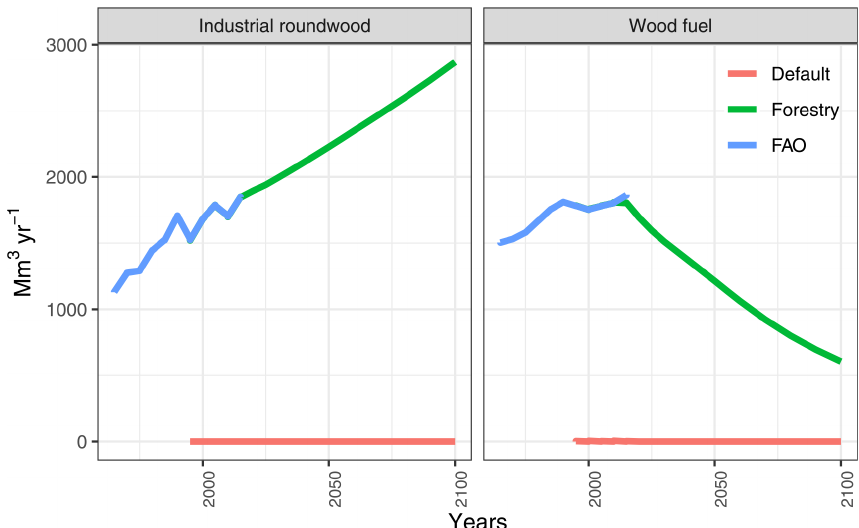
Figure 6. Global industrial roundwood and wood fuel demand between 1995 and 2100 for the MAgPIE forestry scenario (in Mm 3 yr − 1 ). Historical data for validation is based on FAO (2017). The MAgPIE default scenario does not inherently include timber demand.